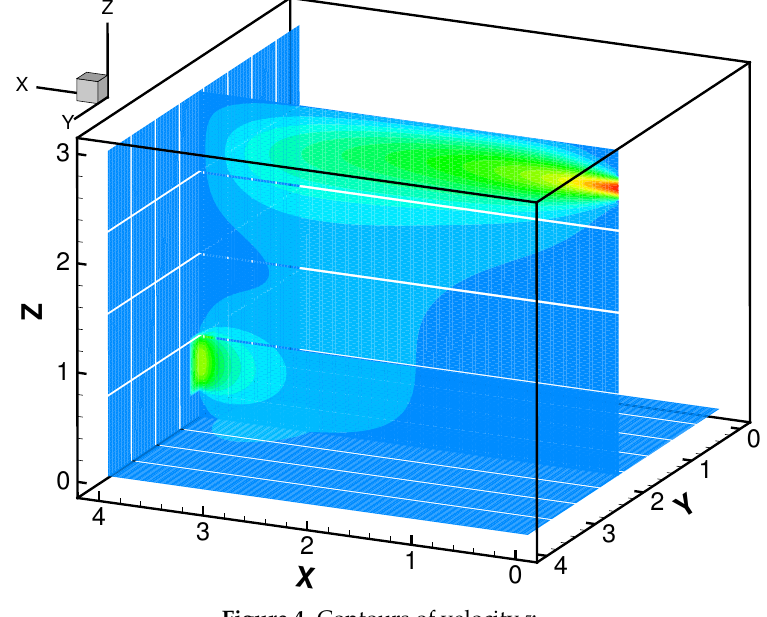
Figure 4. Contours of velocity v 1 .